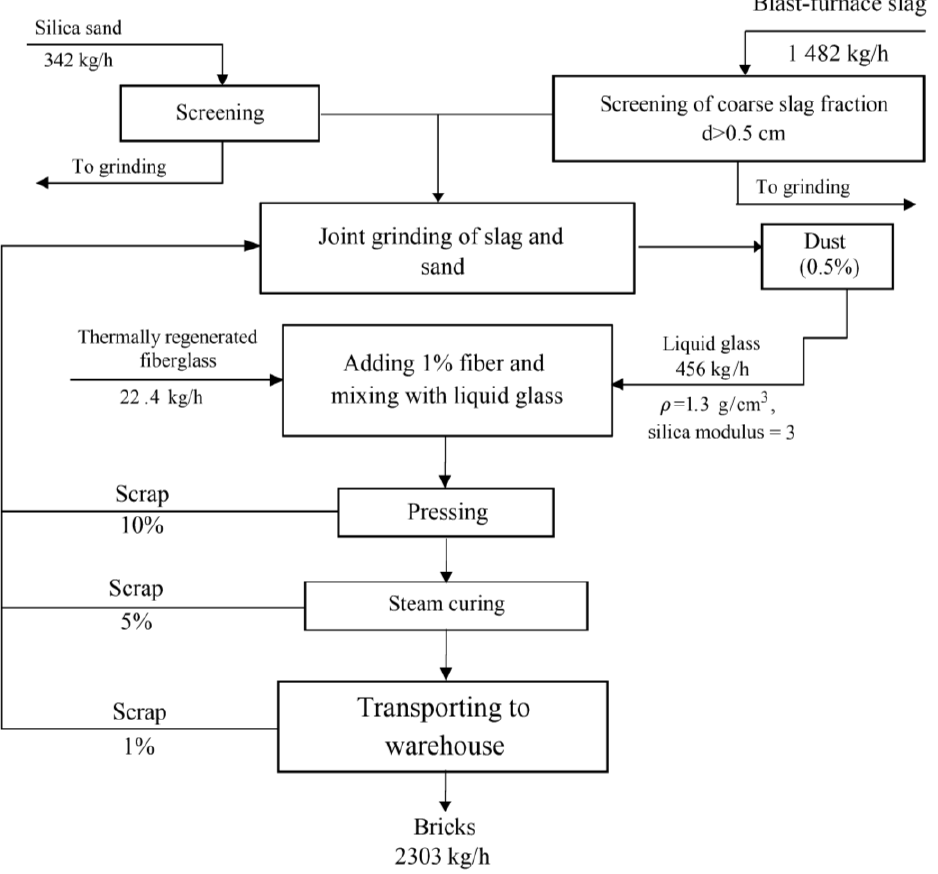
Figure 9. Block flow diagram of fiberglass reinforced bricks